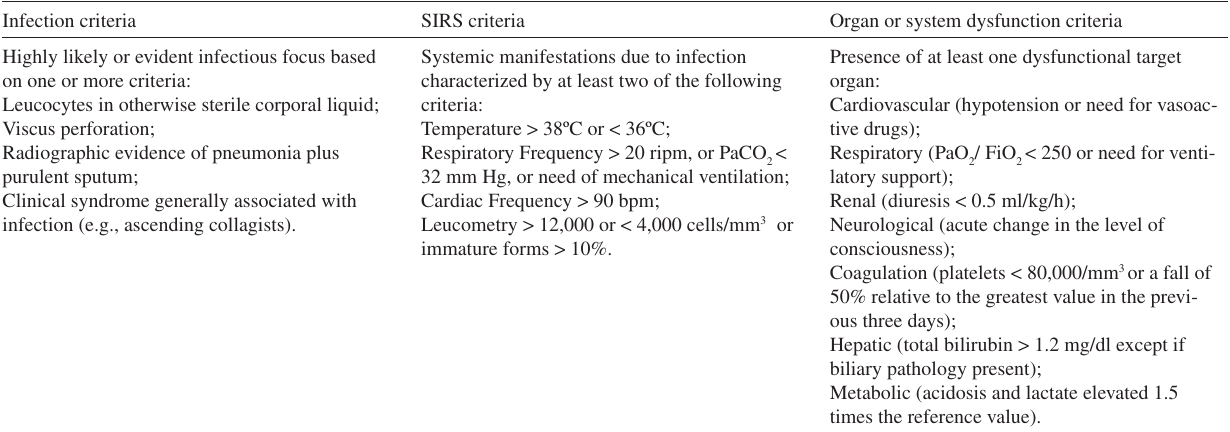
Table 1 - Inclusion Criteria Infection criteria SIRS